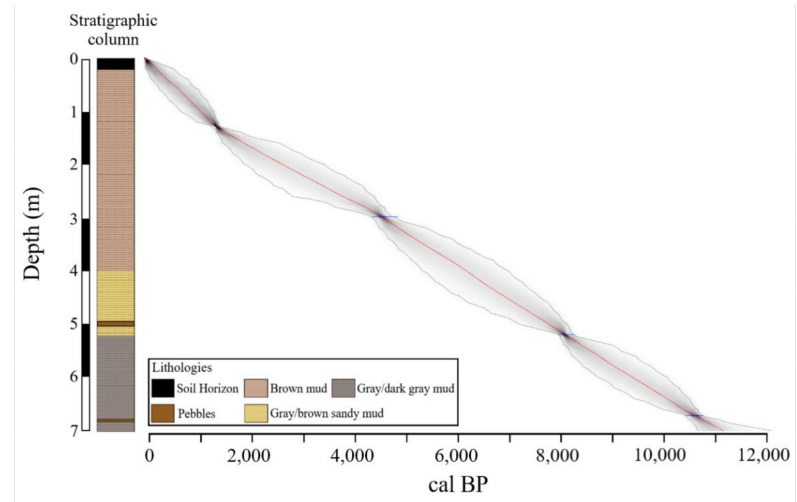
Figure 5. Age–depth model for LS core, constructed using the R package RBacon [21]. The blue tie bars indicate the 14 C age distributions (Table 1). The grayscale of the line graph reflects the likelihood, and the red dotted line follows the mean ages.